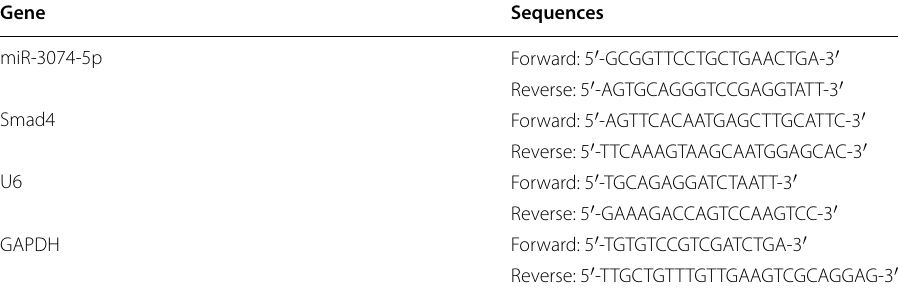
Table 2 Primer sequences for qRT‑PCR